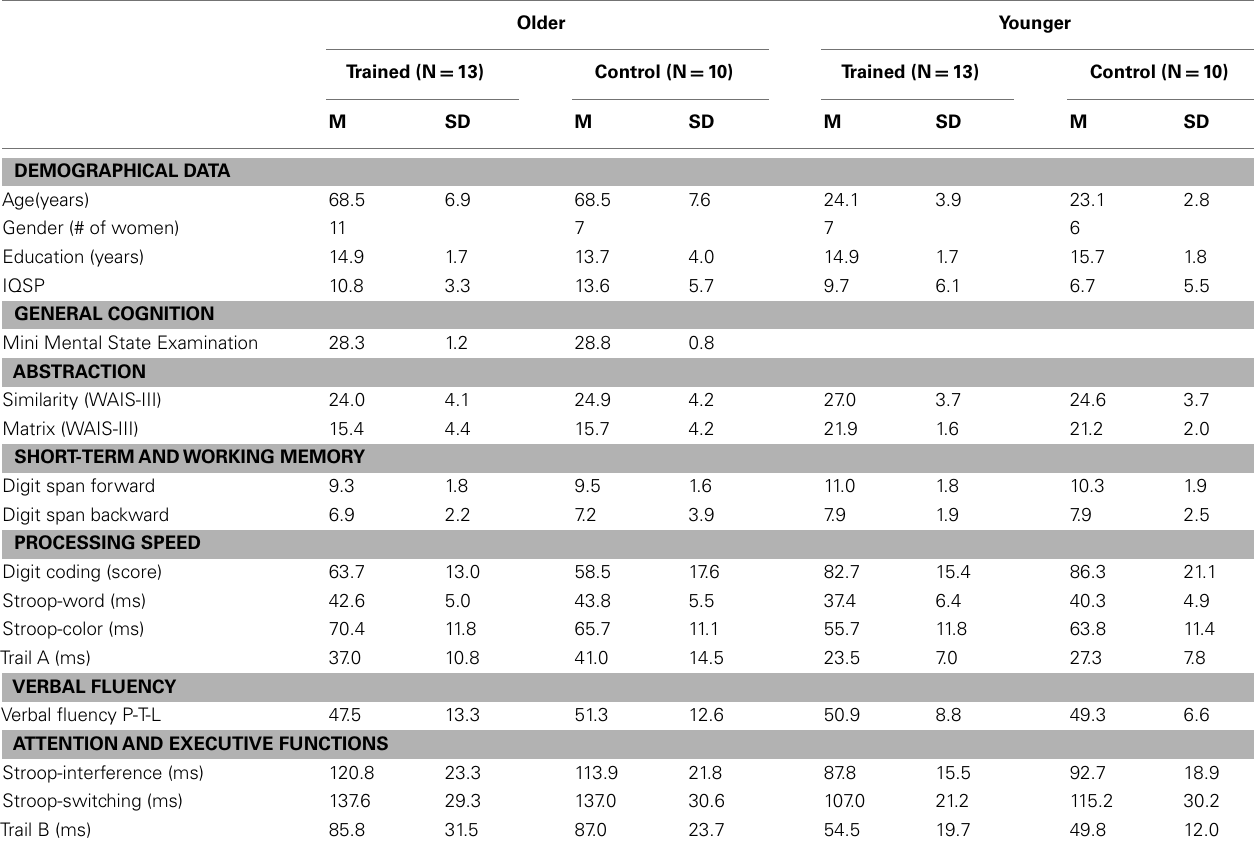
Table 1 | Demographic Data and Performance Scores on theTests Measuring Cognitive